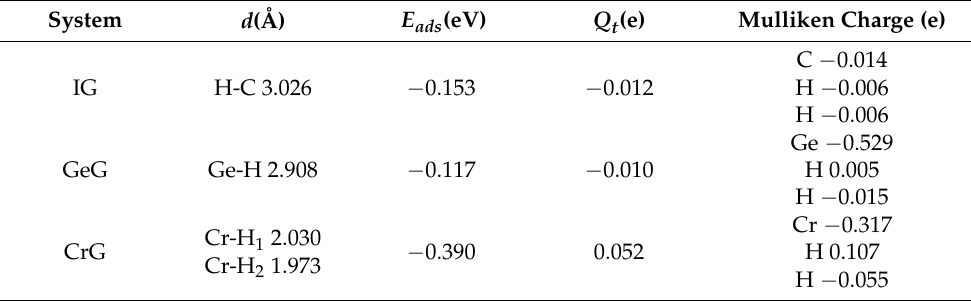
Table 3. The geometrical parameters of H 2 adsorption systems.